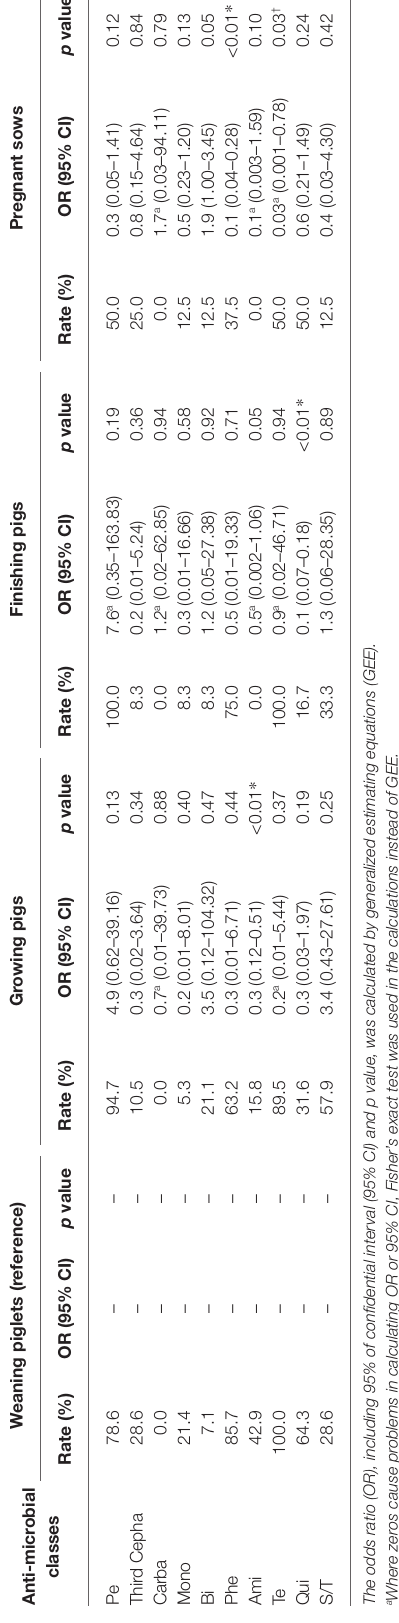
In the comparative genomic analysis based on swine production stages, intestinal pathogenic MCR1-EC showed highly shared virulence factor characteristics between strains with the same clone type. In addition, the patterns of replicon types and antimicrobial resistance genes were also identical with slight differences between strains with the same clone types. Genetic Relatedness Analysis of MCR1-EC Strains Based on Clone Types and WGS Clonal Distribution Analysis of MCR1-EC From This Study and the NCBI Database Among 53 MCR1-EC strains, 38 strains were identified as E. coli phylogenetic group A (71.7%, 38/53), 11 strains (20.8%) were identified as group B1, and four strains (7.5%) were identified as group D ( Figure 6 ). In total, 17 clone types were identified among 53 MCR1-EC strains isolated in this study, and the major clone types were ST10-A (28.3%, 15/53), ST1112-A (15.1%, 8/53), ST744-A (7.5%, 4/53), ST101-B1 (5.7%, 3/53), and ST457-D (5.7%, 3/53). The other clone types included only one or two MCR1-EC strains. In a comparison by swine farm, all clone types were not shared between pig farms with the exception of ST101-B1, which was isolated from three pig farms. In a comparison by swine production stage, the clone types were shared between pigs of different stages within farms ( Figure 3 ). In the clonal distribution analysis of MCR1-EC published in the NCBI database, 17 MCR1-EC strains derived from South Korea harbored 15 clone types, including ST10-A (11.8%, 2/17) and ST11124-A (11.8%, 2/17; Supplementary File 1 ). In the clonal distribution analysis of human-, pig-, and chicken-derived 1,652 MCR1-EC, 248 clone types were identified among 940 human-derived MCR1-EC, and major clone types were ST10-A (9.6%, 90/940), ST152-A (3.5%, 33/940), ST206-A (3.0%, 28/940), and ST101-B1 (2.9%, 27/940). Among 266 pig-derived MCR1-EC strains, 101 clone types were identified, and major types were ST10-A (11.3%, 30/268), ST206-A (4.1%, 11/266), and ST101-B1 (3.8%, 10/266). Among 446 chicken-derived MCR1-EC isolates, 118 clone types were identified and major types were ST10-A 21/446). Genetic Relatedness Analysis Based on cgMLST Between MCR1-EC Strains From This Study and the NCBI Database In the cgMLST-based genetic relatedness analysis of intestinal pathogenic MCR1-EC isolated from this study and South Korea- derived MCR1-EC published on the NCBI database, the genetic T A